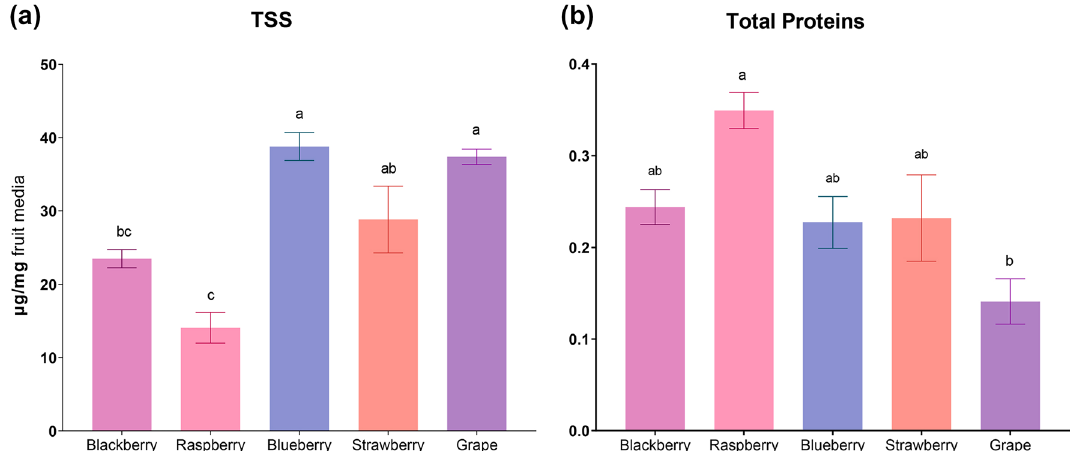
Figure 1. Fruit media nutritional values. ( a ) Total soluble sugars (TSS), ( b ) total proteins. Values are presented as mean ± SEM. Different letters represent statistically significant differences (p <